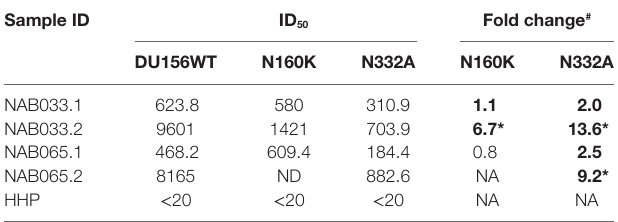
TaBle 5 | Neutralization activity of BCN samples against DU156 pseudovirus with mutations in peptidoglycans targeted by the PG9/PG16 and PGT series of bNAbs.